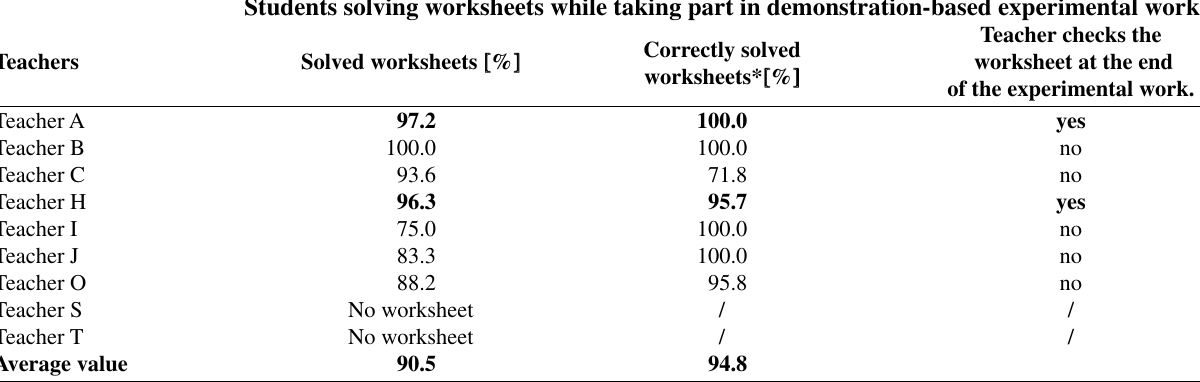
Table 2: Analysis of collected data when evaluating the worksheets, the students used during demonstration-based experimental work. Students solving worksheets while taking part in demonstration-based experimental work